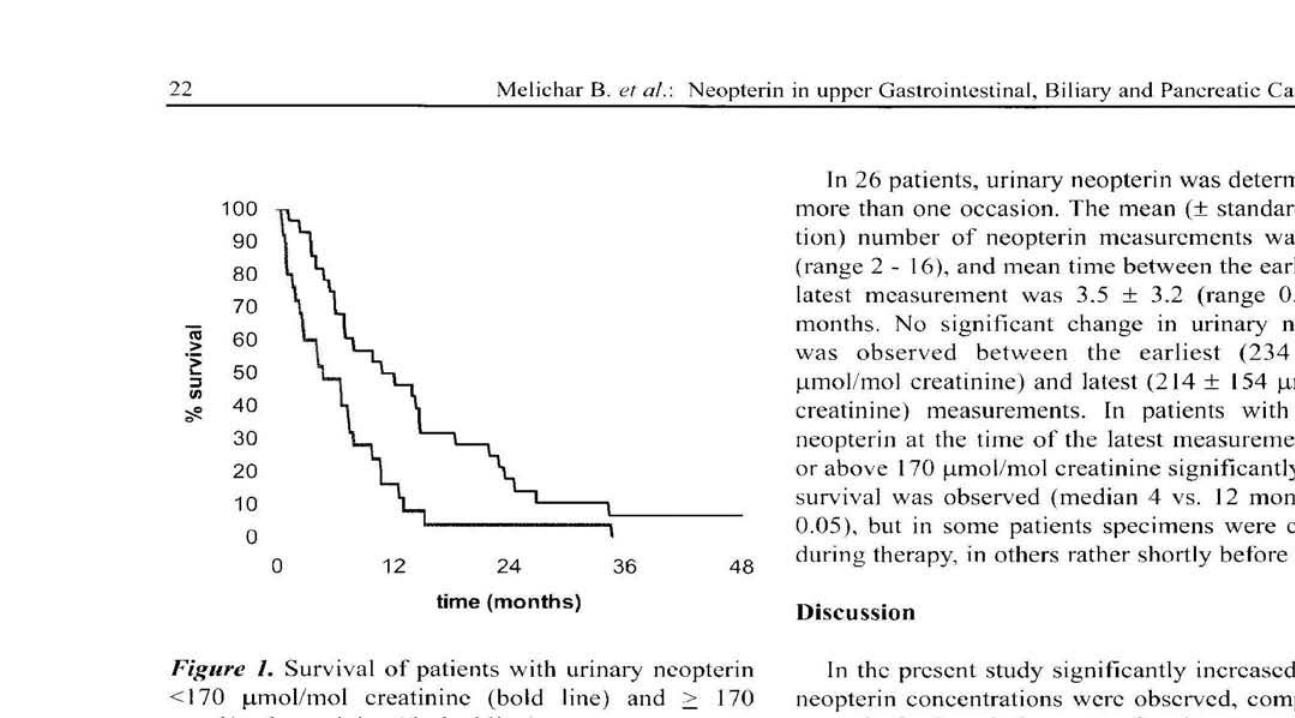
1. Survival of patients with urinary neopterin <170 (amol/mol Creatinine (bold line) and > 170 (amol/mol Creatinine (dashed